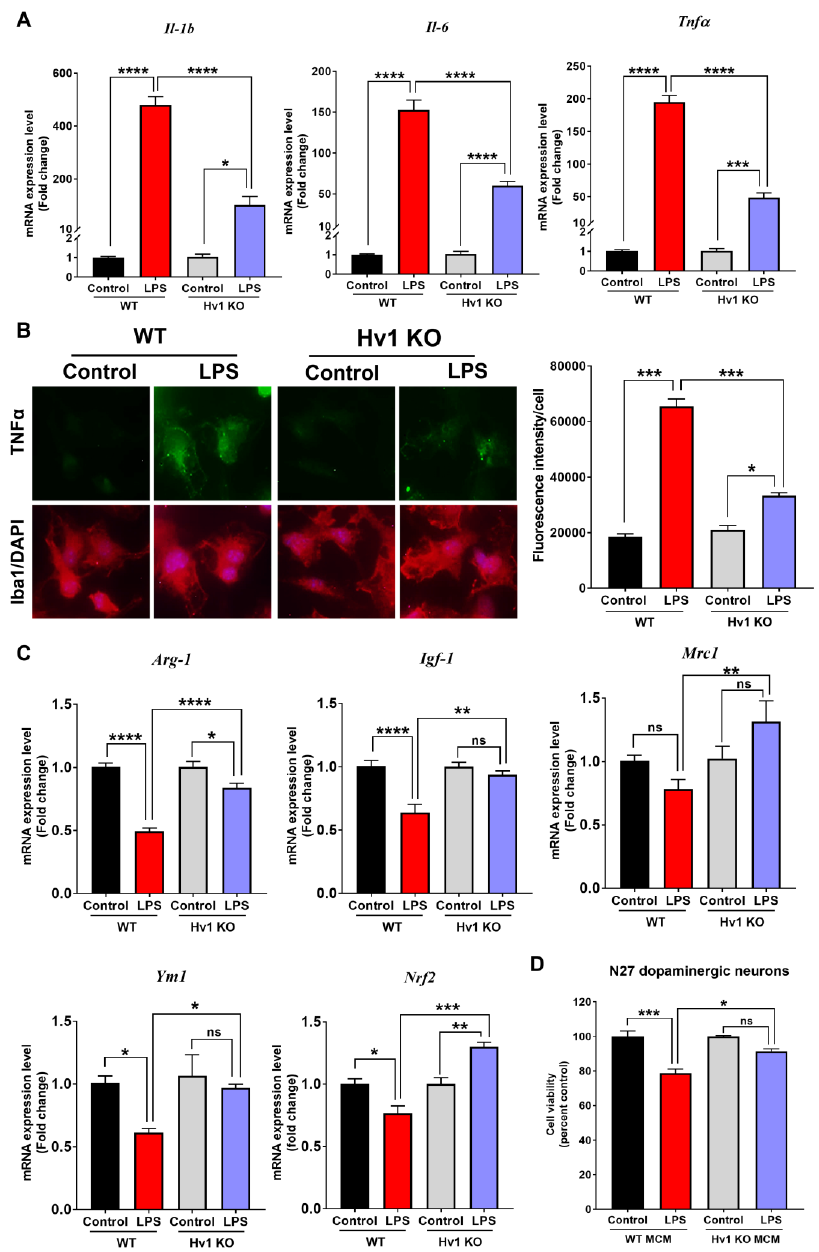
Figure 8. Hv1 KO attenuates LPS-induced inflammatory response in primary mouse microglia and protects dopaminergic neurons from LPS-treated microglial conditioned media. ( A ) Primary microglia isolated from Hv1 KO mouse pups have reduced Hv1 mRNA levels of the inflammatory cytokines Il-1b , Il-6 , and Tnfa by qPCR compared to LPS-treated WT microglia. ( B ) Representative immunofluorescence images for TNF α (green) in Iba1-positive cells (red), with nuclear DAPI stain (blue), scale bar 20 µ m. TNF α fluorescence quantification (right). ( C ) Quantitative PCR gene expres- sion results for the anti-inflammatory genes Arginase-1 , Igf-1 , Mrc1 , Ym1 , and Nrf2 in WT and Hv1 KO primary microglia following LPS treatment. ( D ) Cell viability of N27 rat dopaminergic neurons was measured using MTS reagent that produces a formazan product in metabolically active cells. Media conditioned from primary microglia (microglia-conditioned media or MCM) treated with or without LPS for 24 h was added to N27 cells for 24 h. n = 3 isolations for primary microglia and 3 separate passages for N27 cells. Asterisks denote statistically significant differences—* p < 0.05, ** p < 0.01, *** p < 0.001, and **** p < 0.0001, using two-way ANOVA followed by Tukey’s multiple comparisons. ‘ns’ indicates not statistically significant. Error bars denote the standard error of the